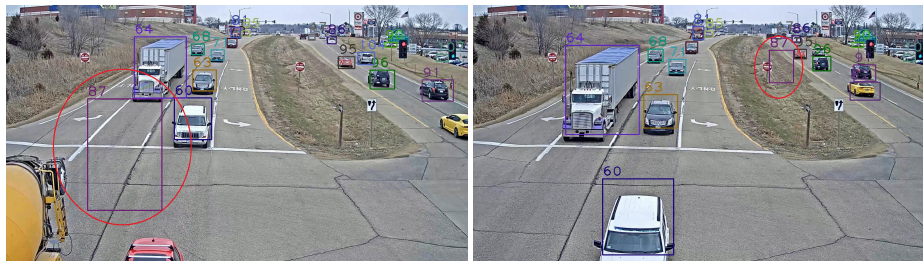
Figure 6. Unreliable tracklet